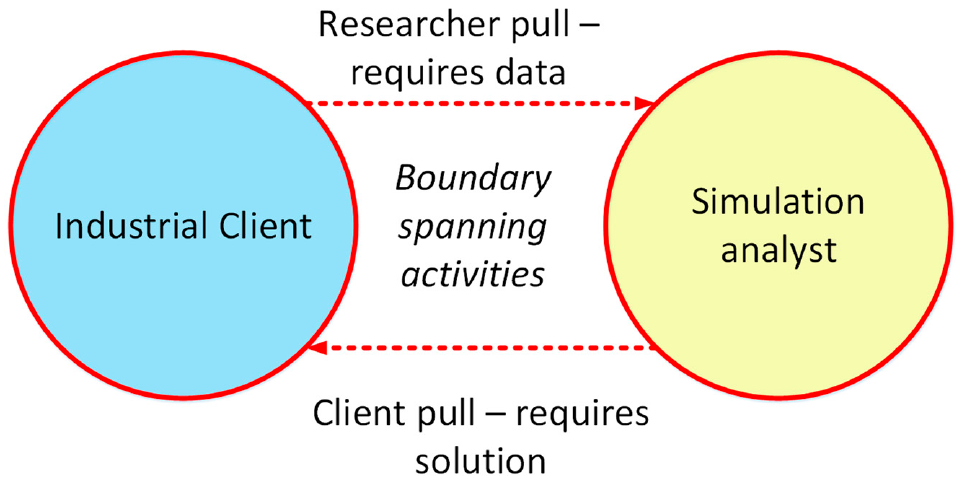
Figure 3. Iterative boundary-spanning activities for mitigating boundary of knowledge.